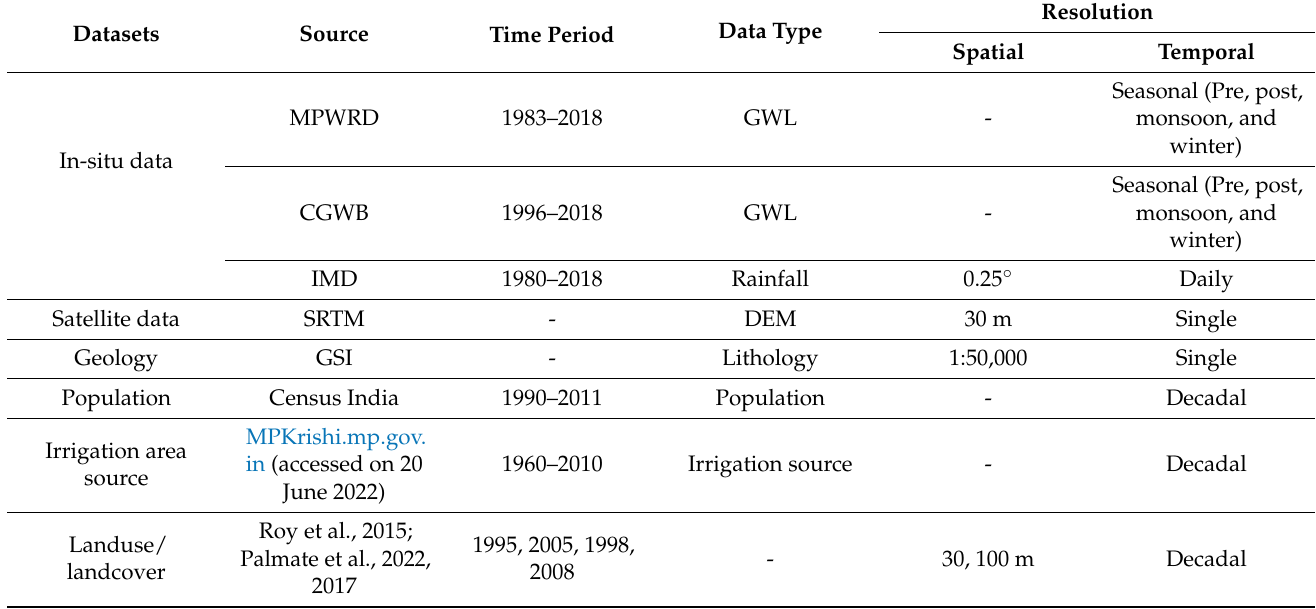
Table 2. List of the datasets (i.e., GWL, rainfall, lithological, and topographical satellite) used for the assessment of groundwater variability in this study. The table shows detailed description of the source, time period, data type, spatial, and temporal resolutions of the